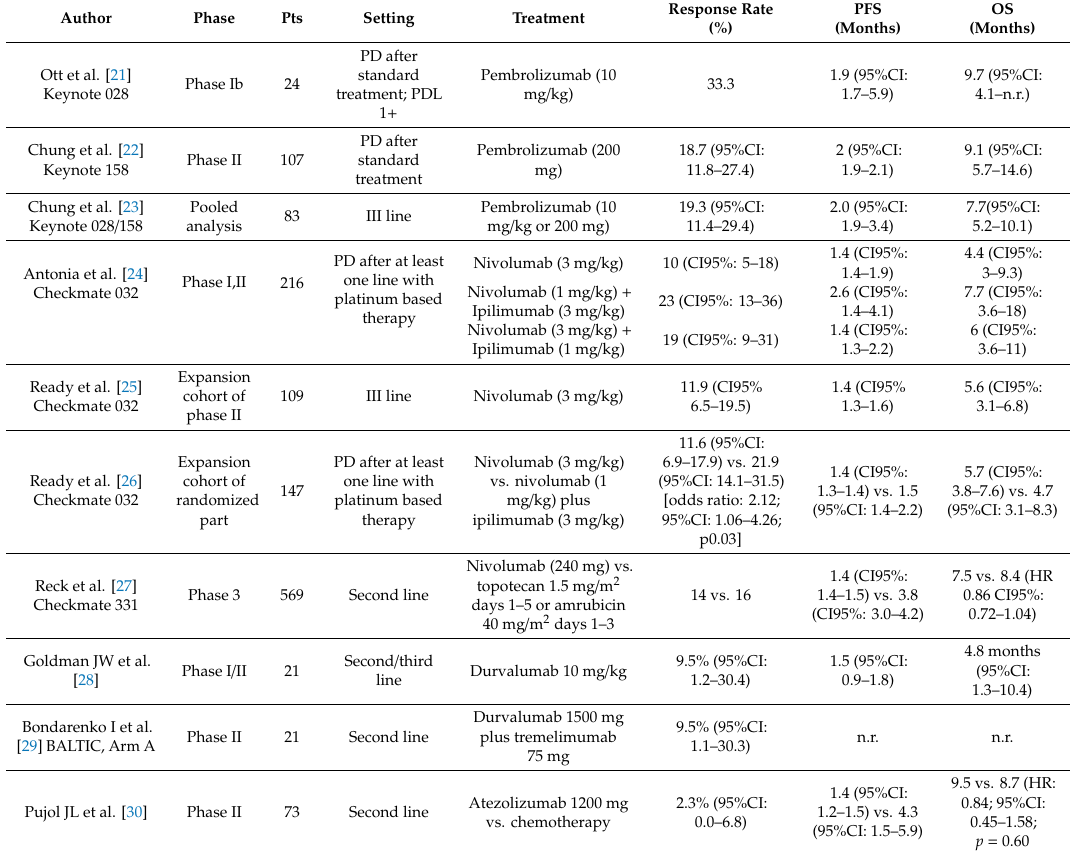
Table 2. Immunotherapy in pretreated SCLC